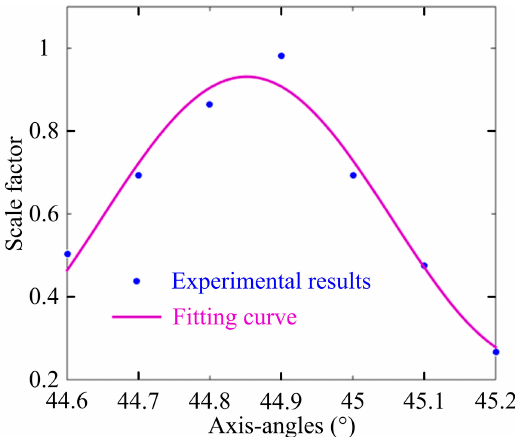
Figure 8. The tendency of scale factor with different axis-angles θ 3 .